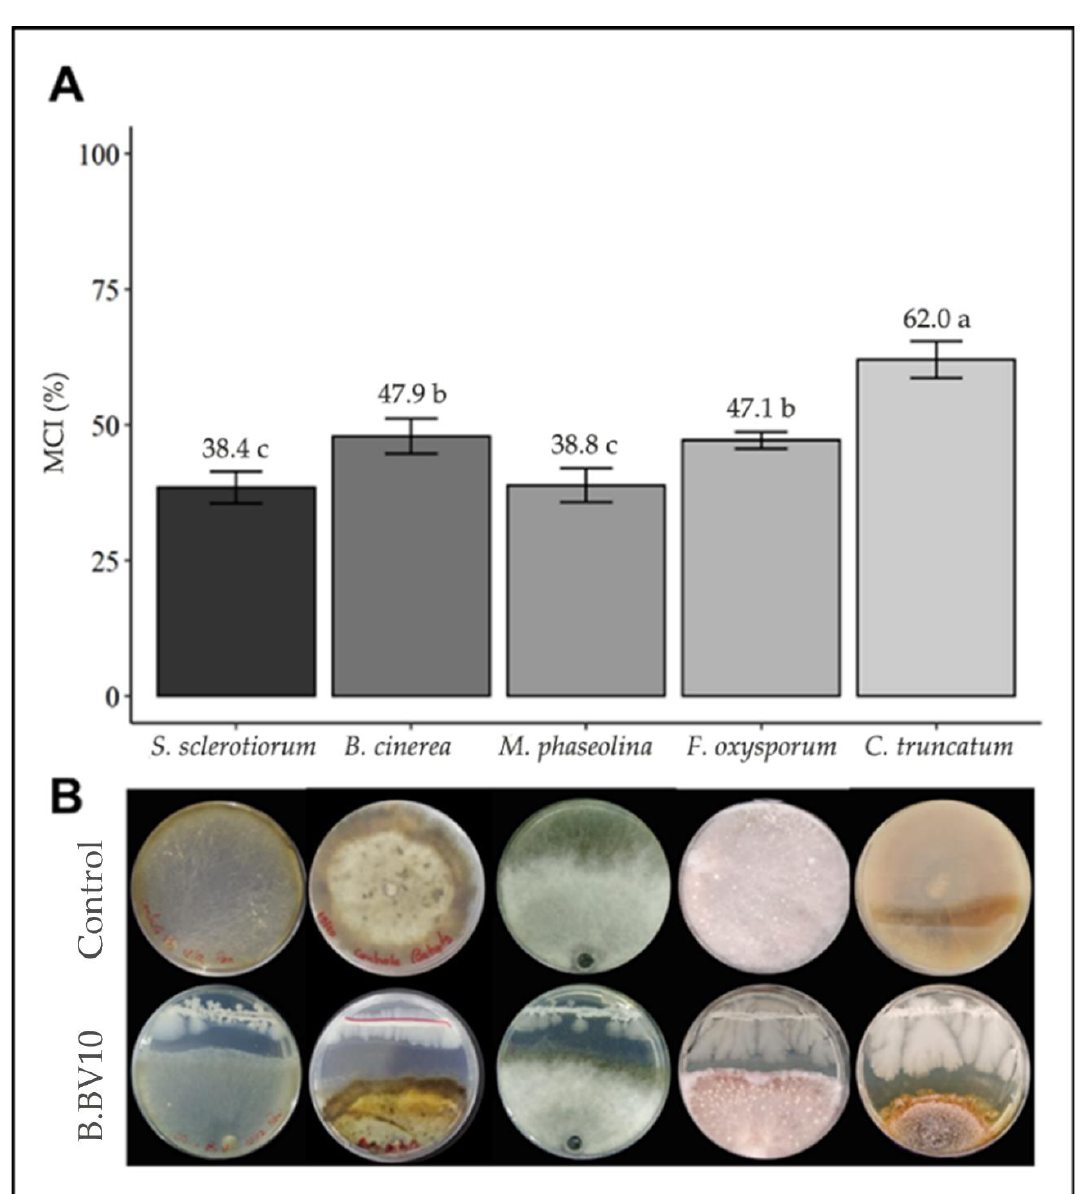
Figure 2. Antagonistic activity of B.BV10 against phytopathogenic fungi. MGI averages (%) were plotted into column charts ( A ), and below are the respective images of the in vitro assays ( B ). Means in each bar followed by the same letter did not differ significantly from each other by the Tukey test ( p < 0.05).